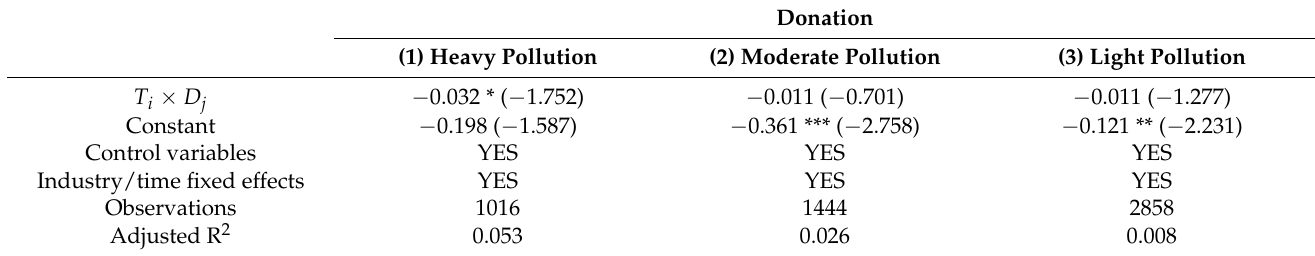
Table 7. The impact of industrial pollution differences.